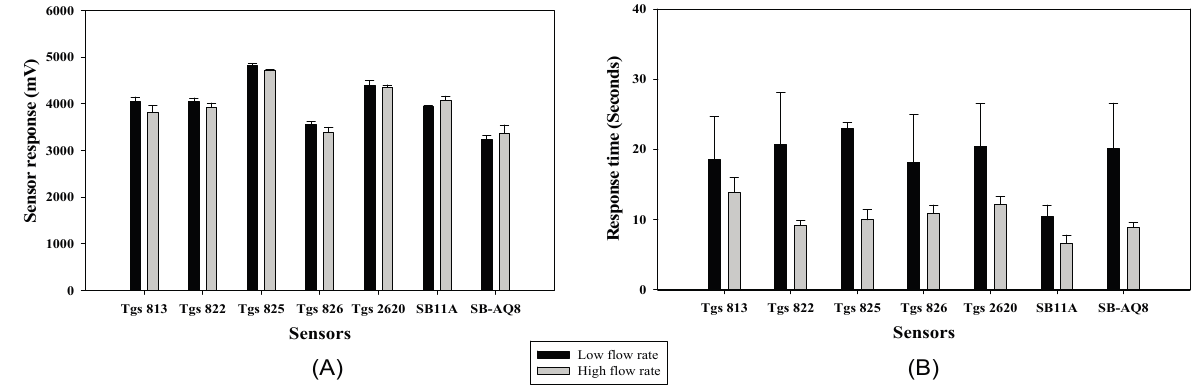
Figure 10. The effect of flow rate on the magnitude of the maximum sensor response ( A ); and the response time ( B